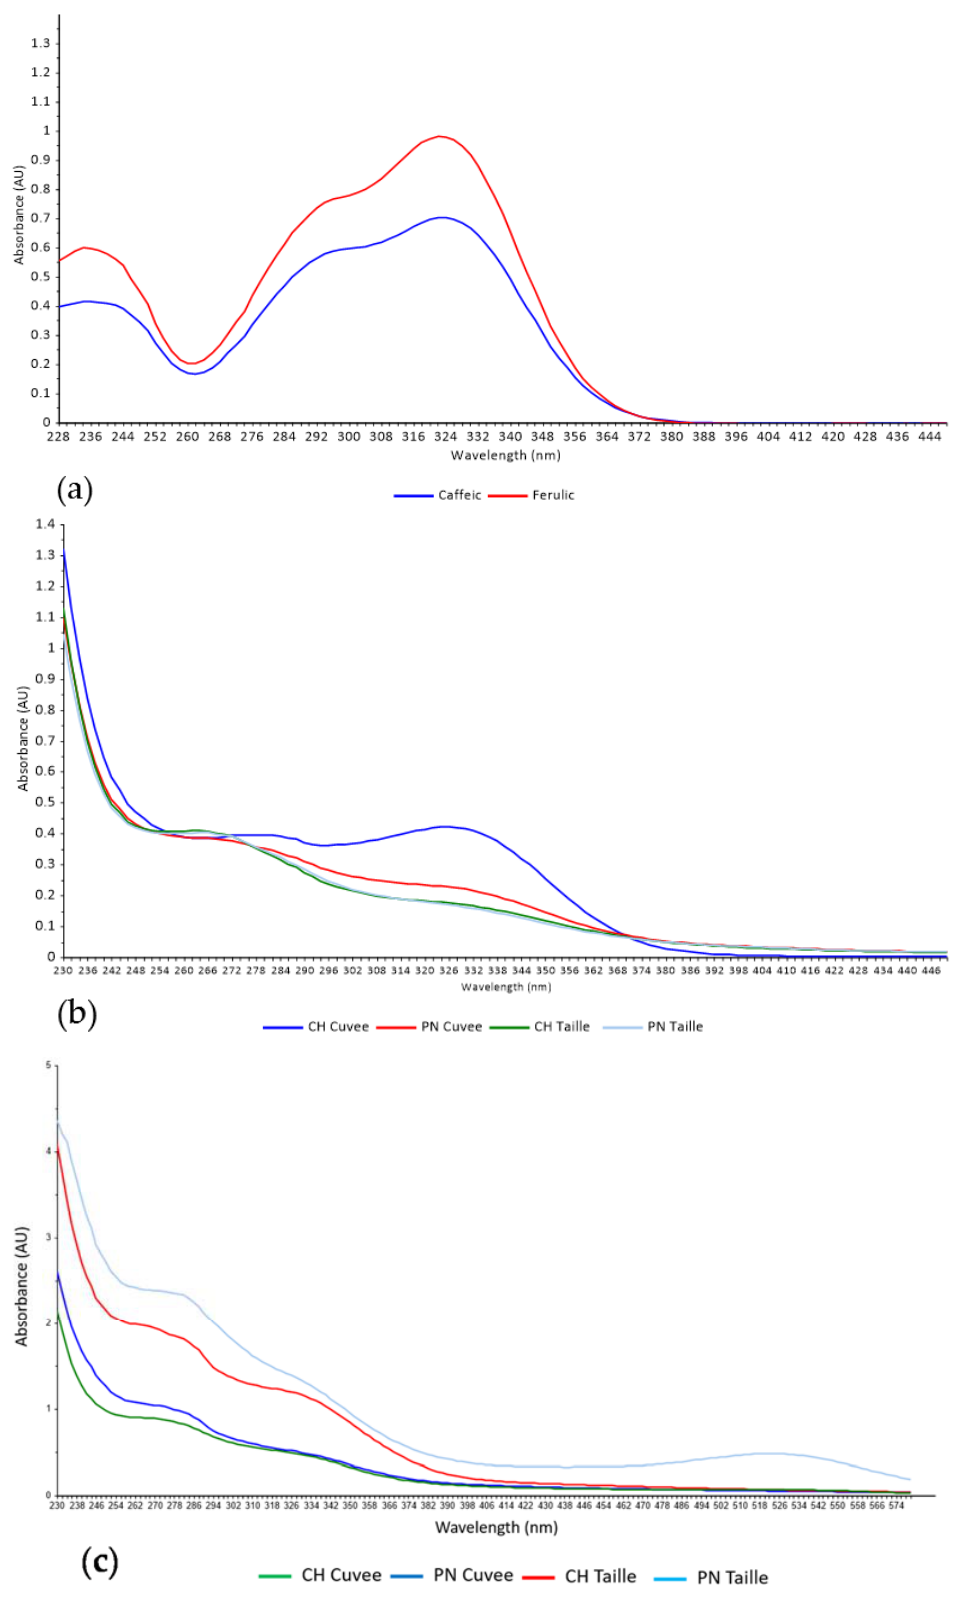
Figure 1. ( a ) Raw UV-Vis spectra of hydroxycinnamate ethanolic solutions, diluted in 1 M HCl; of ( b ) laboratory scale Chardonnay (CH) and Pinot noir (PN) cuvee and taille trials; and of ( c ) commercial scale Chardonnay (CH) and Pinot noir (PN) cuvee and taille trials .